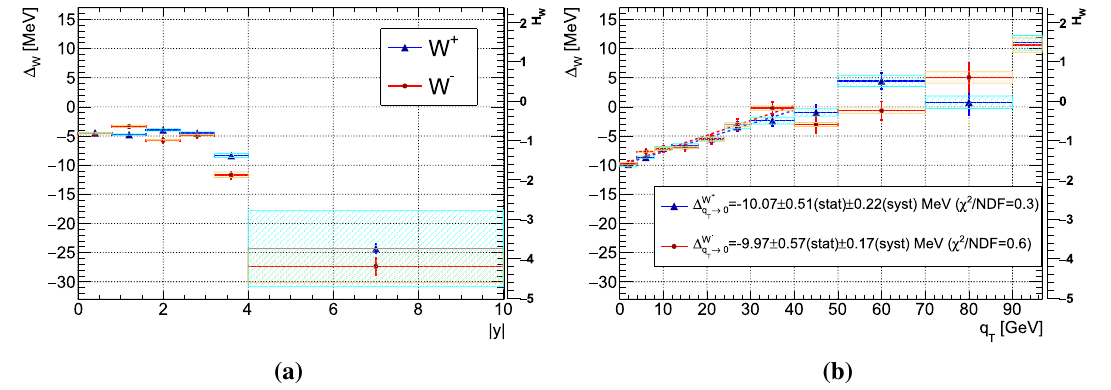
Fig. 5 The shift Δ W ± in bins of the W boson rapidity y (left) and transverse momentum q T (right). For the latter, a linear fit in the range [ 0 , 40 ] MeV is performed to extrapolate the result to q T → 0.